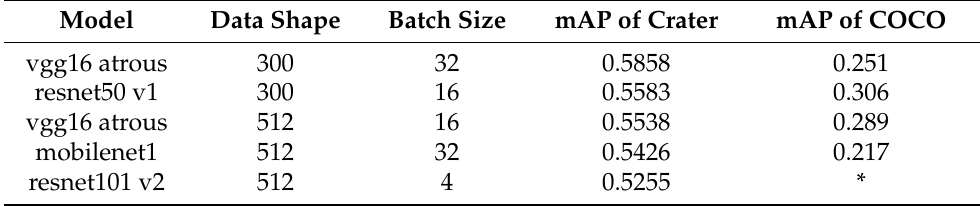
Table 2. Detection experiments on COCO and Red crater datasets using SSD networks. The Red crater dataset is our labeled dataset, excluding other labeled data.